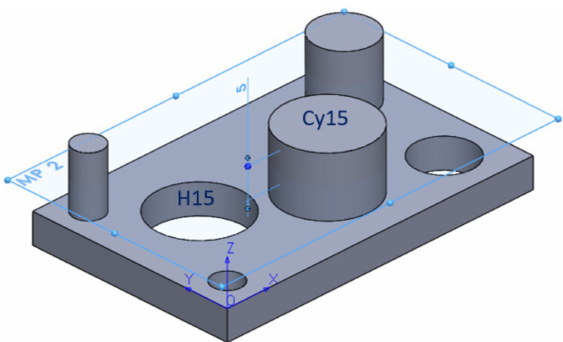
Figure 29. Definition of the cylindrical features and measuring